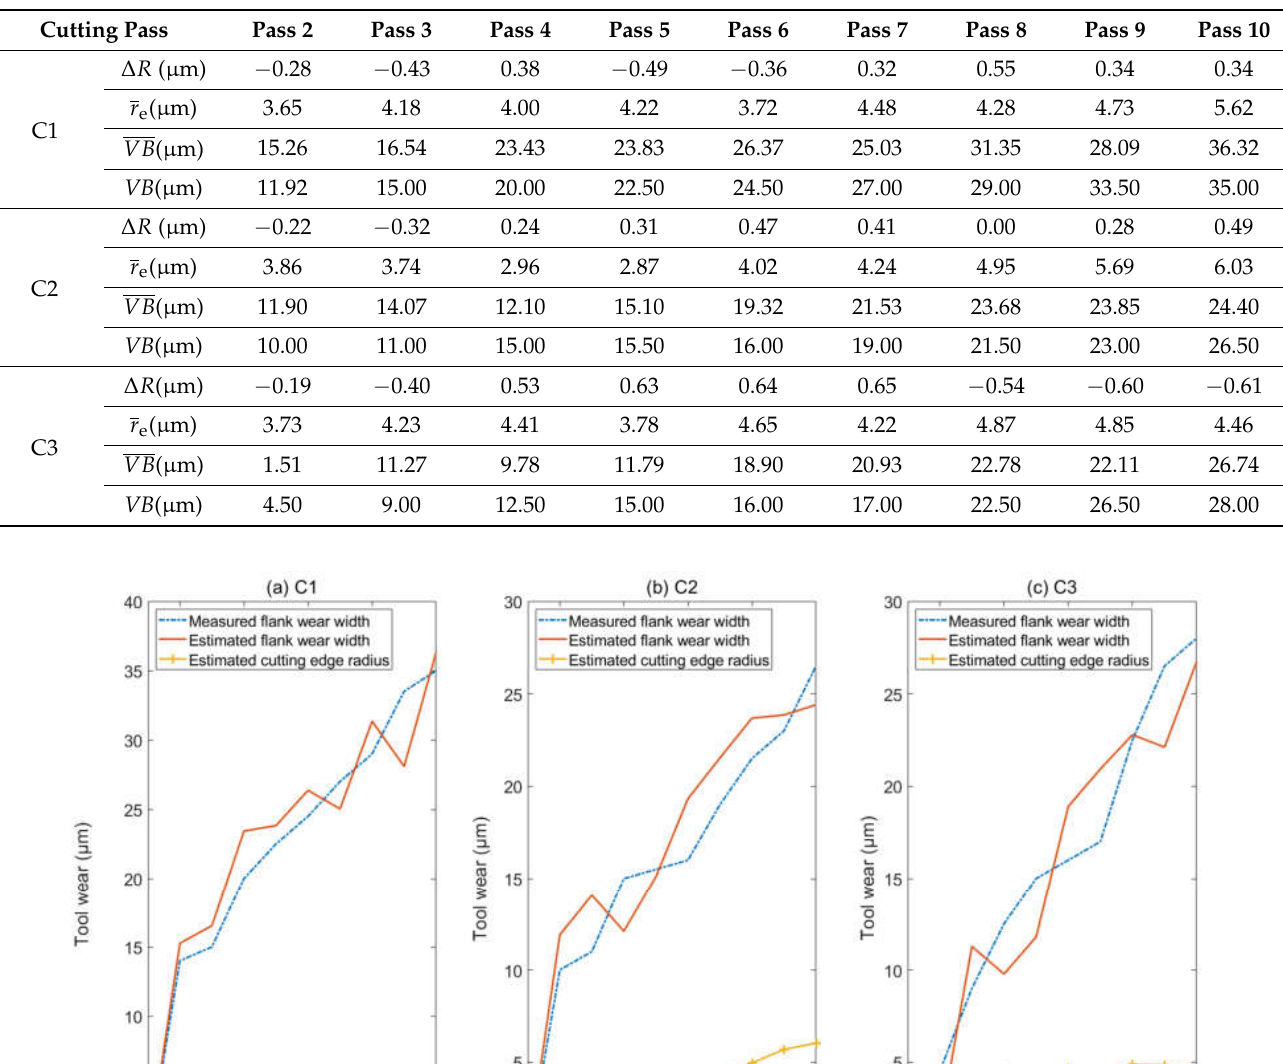
Table 6. Tool wear monitoring results.